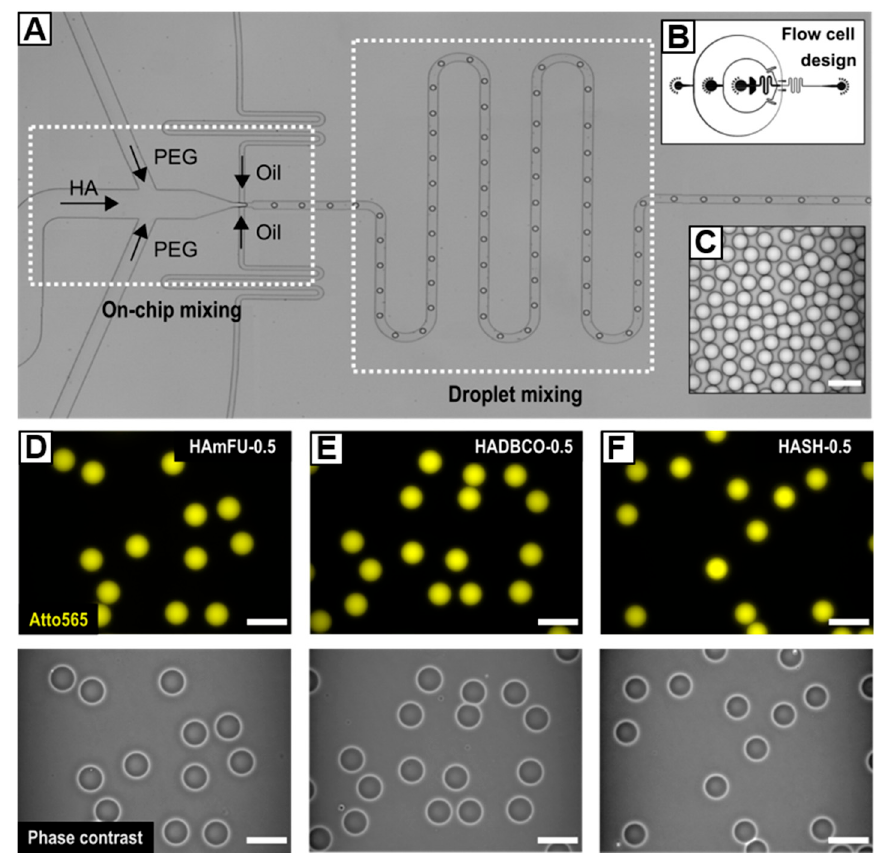
Figure 2. ( A ) Microfluidic flow-focusing device for on-chip mixing of HA-derivates with homobifunctional PEG-crosslinkers. The cross-junction is connected to a serpentine meander structure that induces fast and efficient droplet mixing. ( B ) Corresponding CAD-based schematic of the flow cell. ( C ) Exemplarily W/O emulsion showcasing the preparation of uniform droplets. ( D – F ) HA-microgels in PBS prepared from (D) HAmFU, (E) HADBCO, and (F) HASH via crosslinking with 0.5 Eq of homobifunctional PEG-crosslinkers. Upper row: Fluorescence microscope images of HA-microgels labeled with Atto565 (yellow). Bottom row: Corresponding phase-contrast images. All scale bars denote 50 µm.